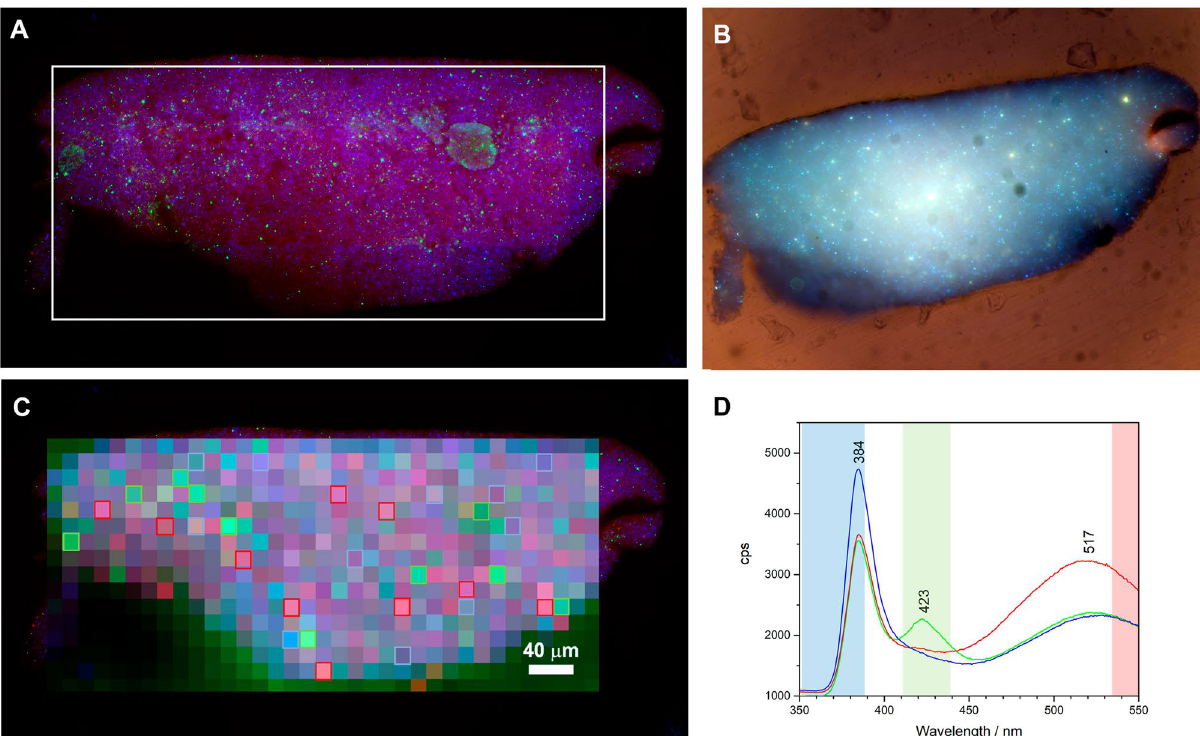
Figure 7. ( A ) Full-field luminescence imaging by TELEMOS of the American flag celluloid advertisement pin (λ exc = 290 nm, 40 × objective). Emission bandpass filters used: 352–388 nm (blue); 412–438 nm (green); 535– 607 nm (red). The white-square marks indicate the POLYPHEME map area. ( B ) Spatially registered false-colour RGB image of the emission at excitations of 365 (blue), 385 (green) and 405 nm (red) with emission bandpass filter 514 nm (30 nm FWHM). ( C ) Raster scanning map by POLYPHEME (15 × 15 µm 2 , 5 s, 2 accumulations, λ exc = 290 nm). Colors were designated as follows: blue for the band edge emission at 385 nm, green for the spectral region between 400 and 450 nm; red for the region between 510 and 550 nm. ( D ) Average spectra calculated from 10 points for each designated color: strong near band edge emission (blue); contributions of ZnO crystal defect emissions between 400 and 450 nm (green) and strong green band emission (red). The spectral points used are marked in the POLYPHEME map ( C ) with squares of the correspondent color. The spectral regions viewed using TELEMOS setup are highlighted, with colours corresponding to the bandpass filters